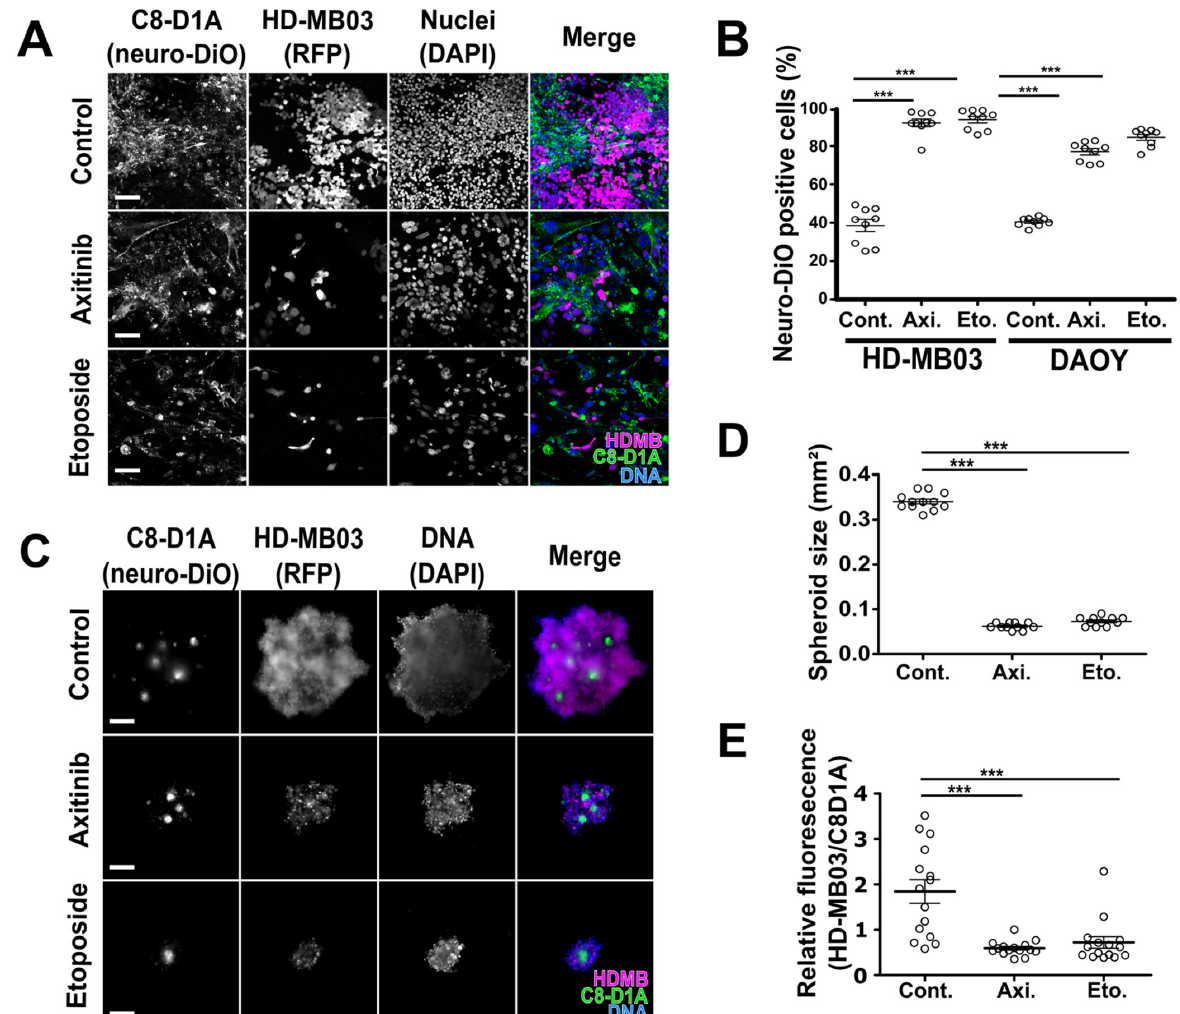
Figure 2. Axitinib selectively impacts proliferation of MB cells in 2D models. ( A ) Confocal images of neuro-DiO-stained primary astrocyte (C8-D1A, green) and RFP-expressing MB cell (HD-MB03, magenta) cocultures treated for 4 days with 5 µM axitinib (Axi.) or 1 µM etoposide (Eto.) (Hoechst 33342 nuclear DNA counterstain is shown in blue; scale bars: 100 µM). ( B ) FACS quantification of neuro-DiO-positive C8-D1A cells relative to the total number of cells according to the cocultured MB cell line (HD-MB03 or DAOY) and the treatment (Axi.: 5 µM axitinib; Eto.: 1 µM etoposide) (horizontal lines and error bars represent the means ± SEM and all individual datapoints of the three independent experiments are plotted; *** p < 0.001, one-way ANOVA test, the results are statistically nonsignificant unless otherwise stated). ( C ) Mixed spheroids generated with neuro-DiO-stained astrocytes (C8-D1A, green) and RFP-expressing MB cells (HD-MB03, magenta) treated for 7 days with 5 µM axitinib or 1 µM etoposide (scale bars: 250 µM). ( D ) Dot plots showing the endpoint size measurements of the C8-D1A/HD-MB03 mixed spheroids treated with the indicated compounds. ( E ) Dot plots showing the relative fluorescence of HD-MB03 and C8-D1A cells (data collected from at least three independent experiments are presented; the bars represent the means ± SEM; *** p < 0.001, one-way ANOVA test, the results are statistically nonsignificant unless otherwise stated).